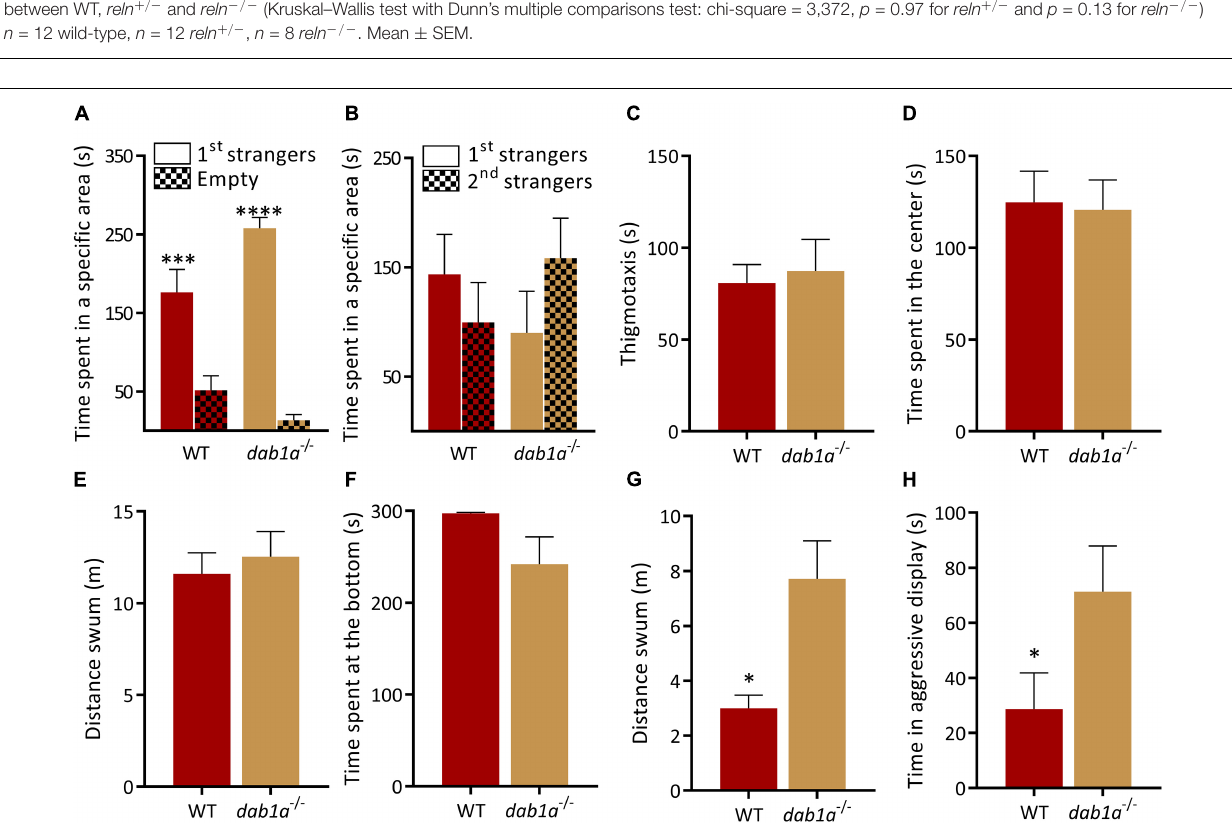
FIGURE 4 | Behavior of dab1a − / − zebrafish. (A,B) Social preference test. (A) Both genotypes prefer to spend time near a group of unfamiliar fish [1st strangers; p = 0.0005 and p < 0.0001 respectively; two-way ANOVA followed by Sidak’s post hoc , genotype factor: F (1,30) = 0.9841, p = 0.3291, stranger